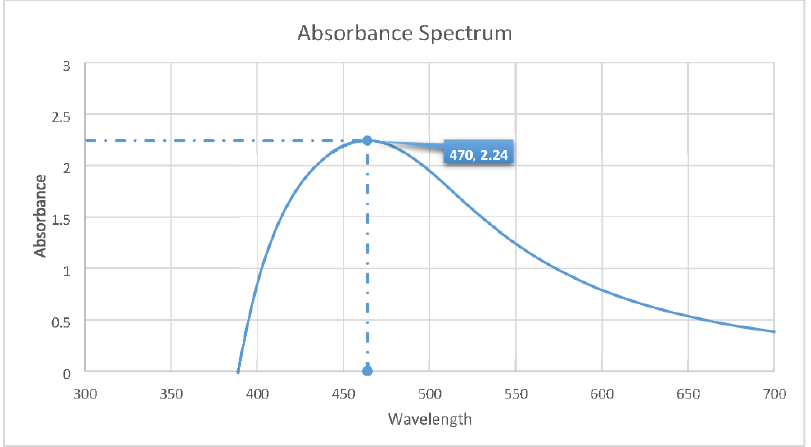
Figure 2. Absorbance spectrum of synthesized AgNPs. The highest absorbance was observed at 470 nm, with an absorbance of 2.24. After 470 nm, the absorbance slowly starts to drop, and the lowest absorbance recorded was 0.5 while the absorbance continues to go lower. There is no absorbance observed before an SPR of about 390.